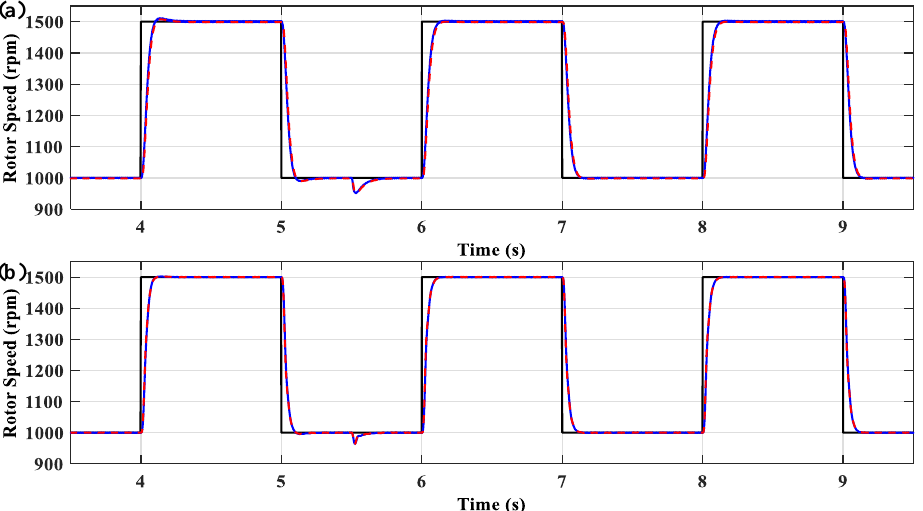
Figure 13. Comparison of the speed response of simulation results in the case of the varied external load for R L = 100 → 50 Ω: ( a ) PI controller; and ( b ) NFC controller.